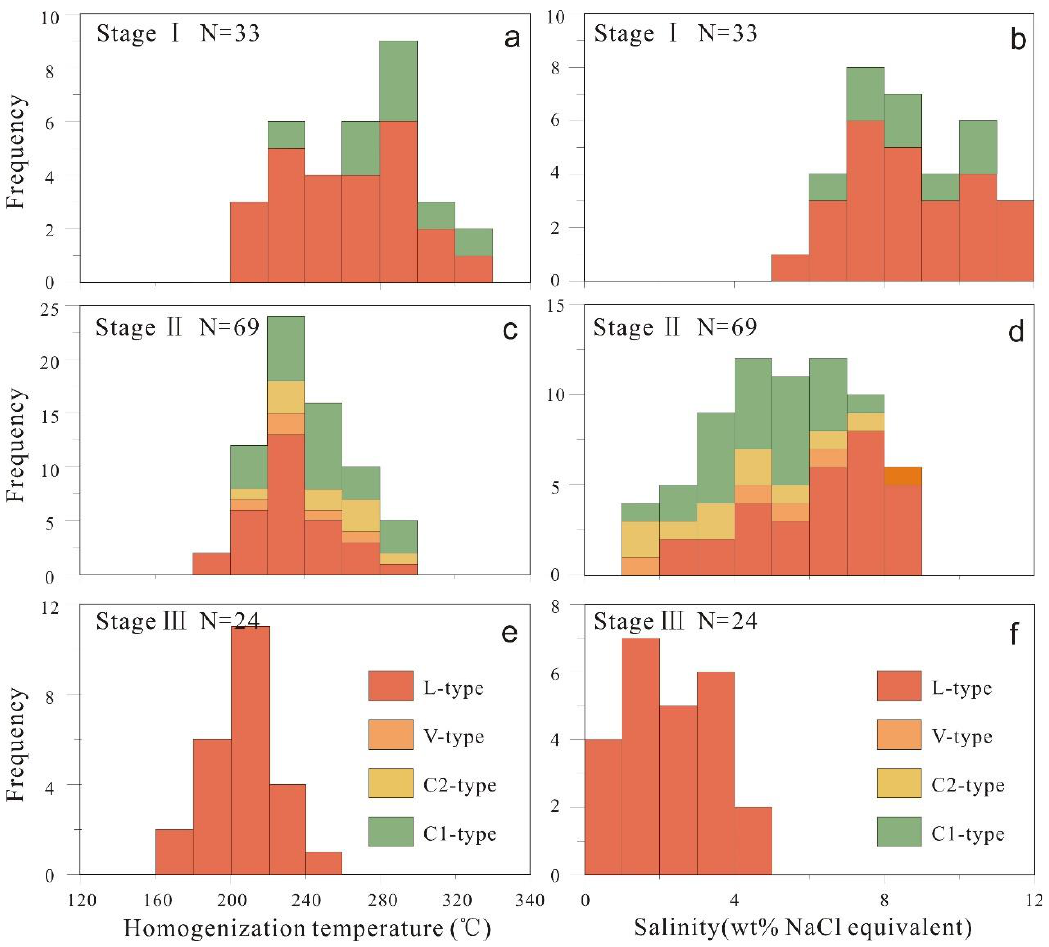
Figure 6. ( a – f ) Histograms of total homogenization temperatures (Th) and salinities of FIs from three hydrothermal mineralization stages.